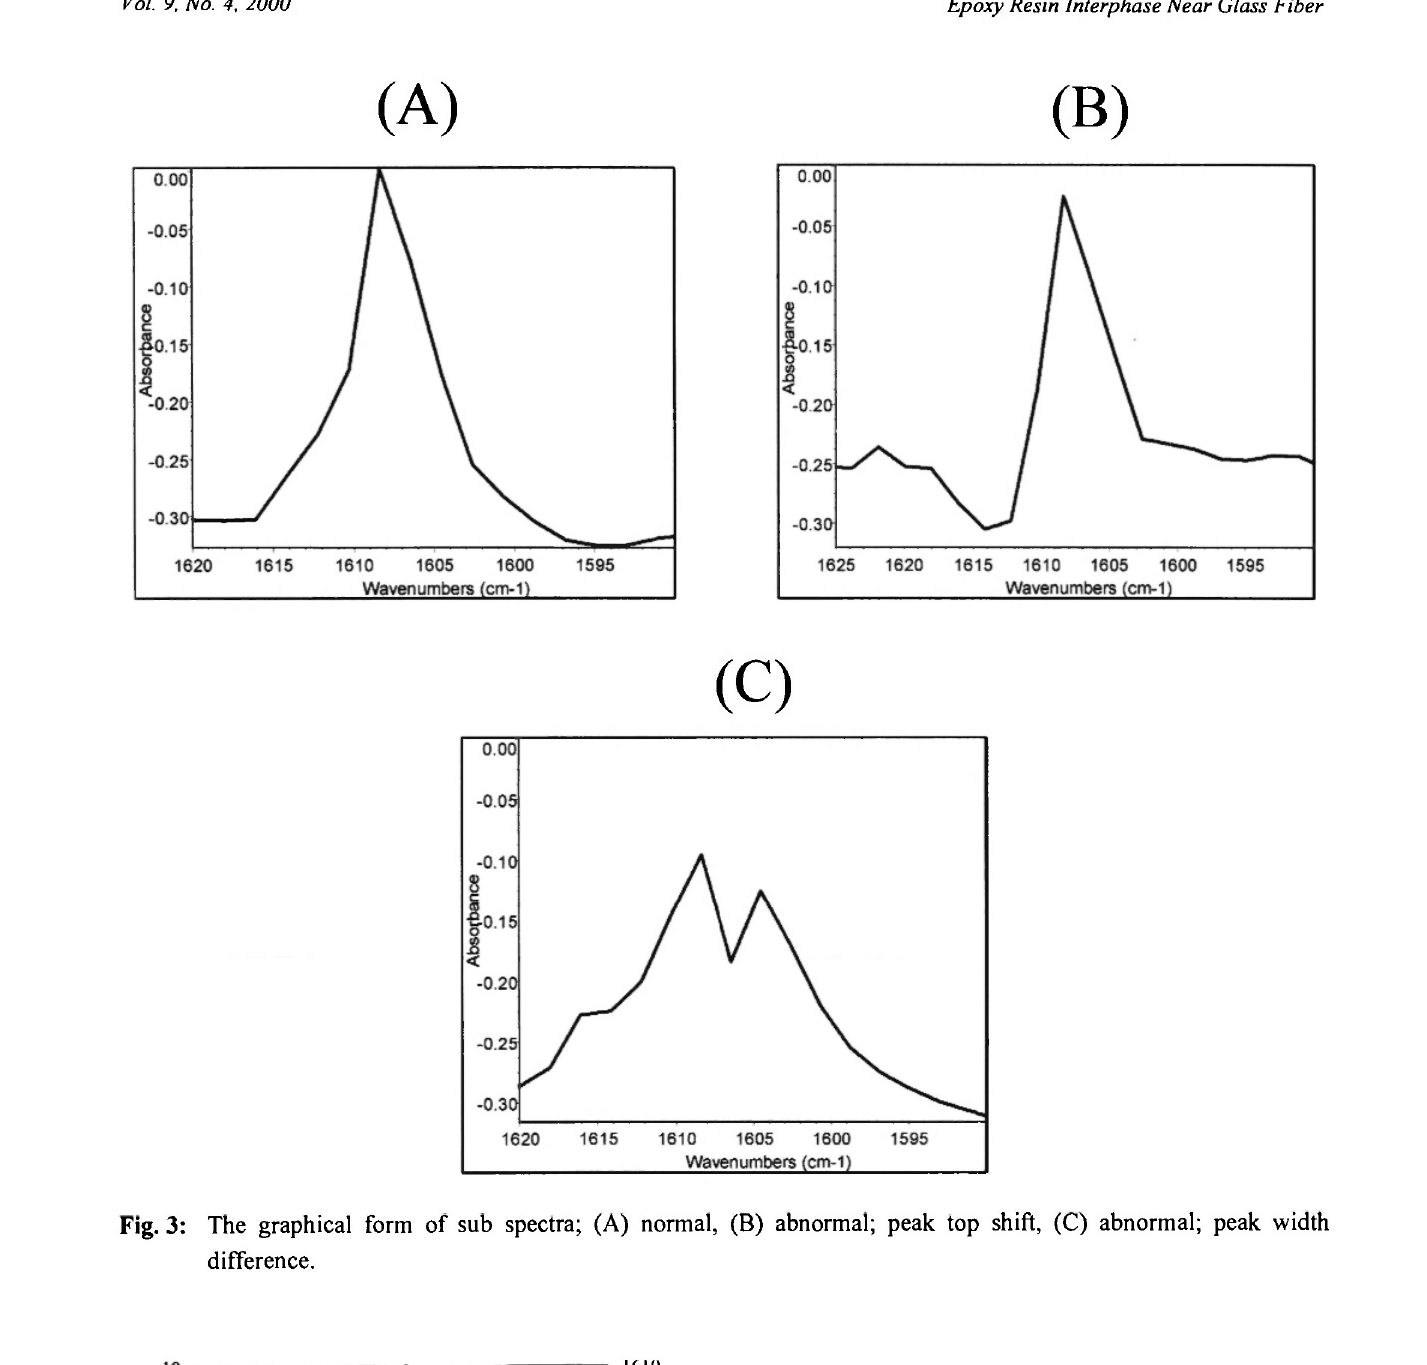
Fig. 4: Wave number and number of silane-treated glass fiber in a window of 20 μηι χ 40 μιτι as a function of distance in epoxy resin; wave number (•), number of glass fiber (•), and wave number average of five point